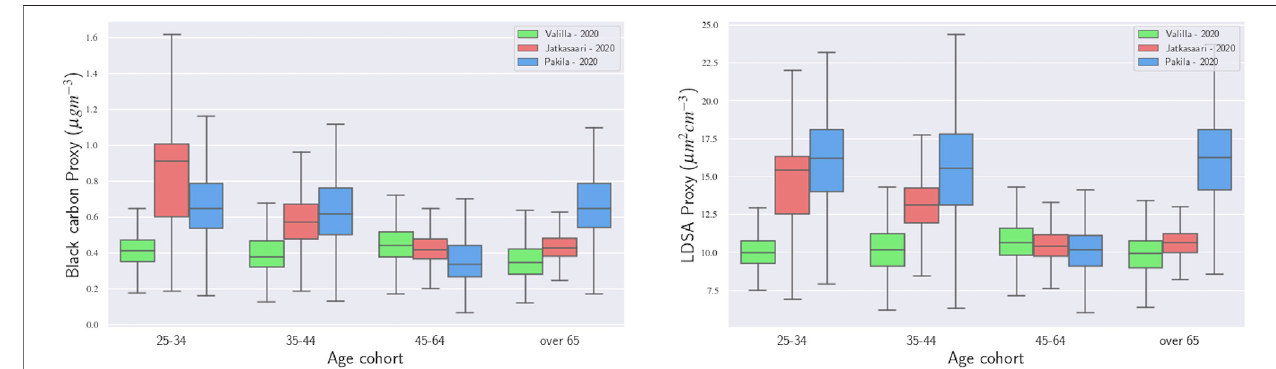
FIGURE 9 | Hourly black carbon and lung deposited surface area (LDSA) proxy concentrations derived from HOPE sensors measurements compared to participants age groups for campaigns 2019 – 2020.